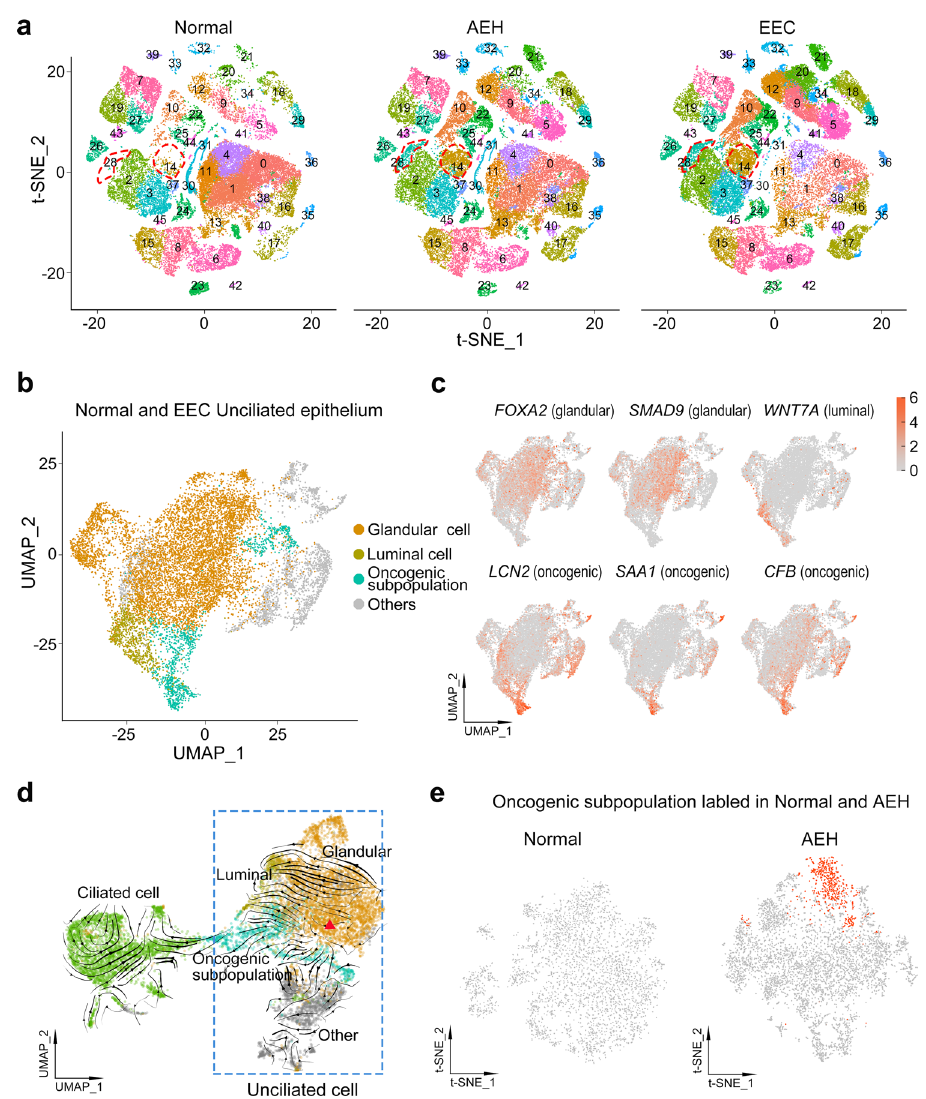
Fig.3|Unciliatedglandularepitheliumisthesourceofendometrialcarcinoma. a Split t-SNE plots of Fig. 1b for detail clusters show that clusters 14 and 28 are arising during tumor progression. b , c t-SNE plot of unciliated epithelium cell of normalandEECshowingdistribution( b )andmarkergenespattern( c )ofglandular cell,luminalcell,andoncogenicsubpopulation. d RNAvelocityuponUMAPplotof